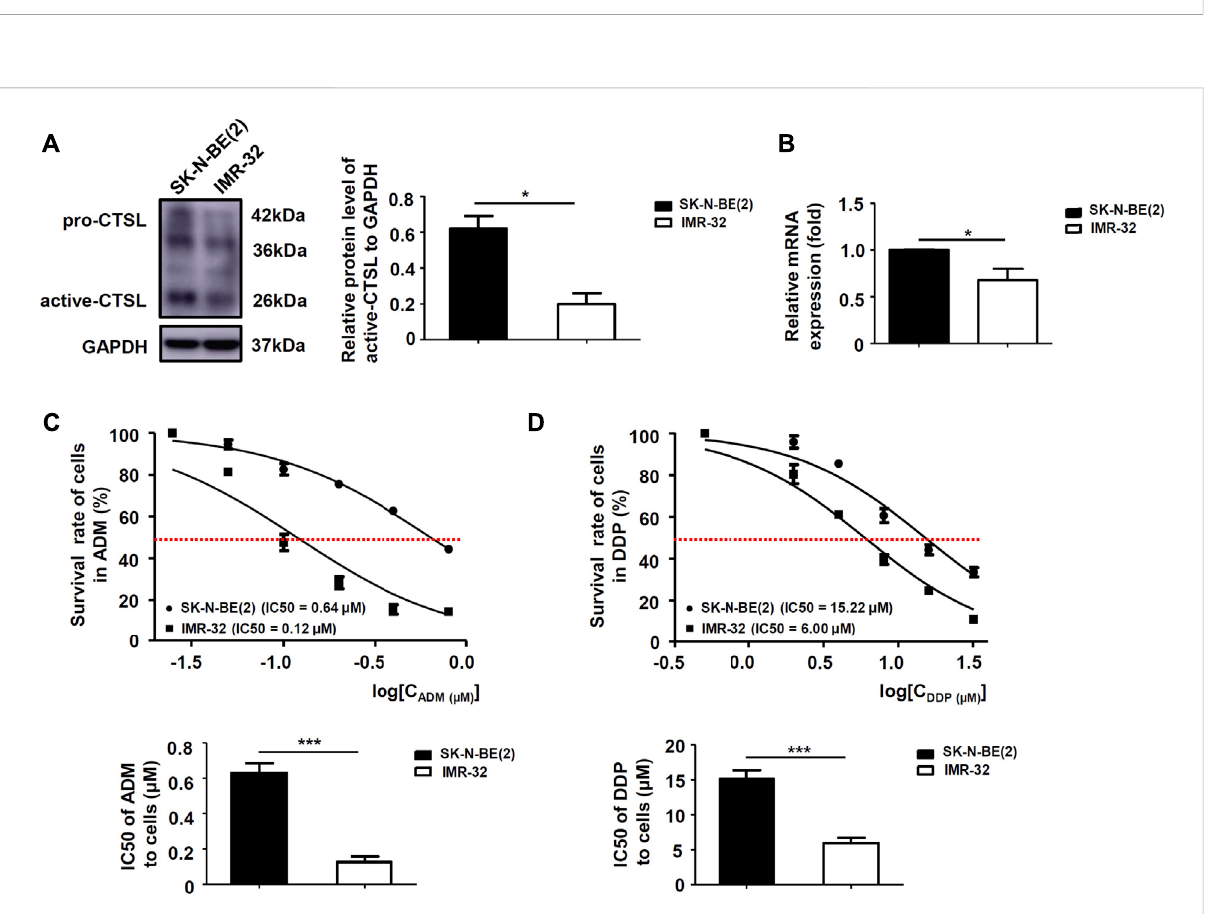
FIGURE 2 The expression of CTSL was associated with ADM and DDP sensitivity in NB cells (A) Western blot analysis and (B) real-time quantitative PCR analysis of CTSL levels in SK-N-BE (2) cells and IMR-32 cells. Cell viability curves for the two NB cell lines after ADM (C) and DDP (D) treatment were evaluatedusingthecellcountingkit-8assay(upperpanel).TheIC50valueswereanalyzedusingtheMann-Whitneytest(lowerpanel).*, p < 0.05,***, p <